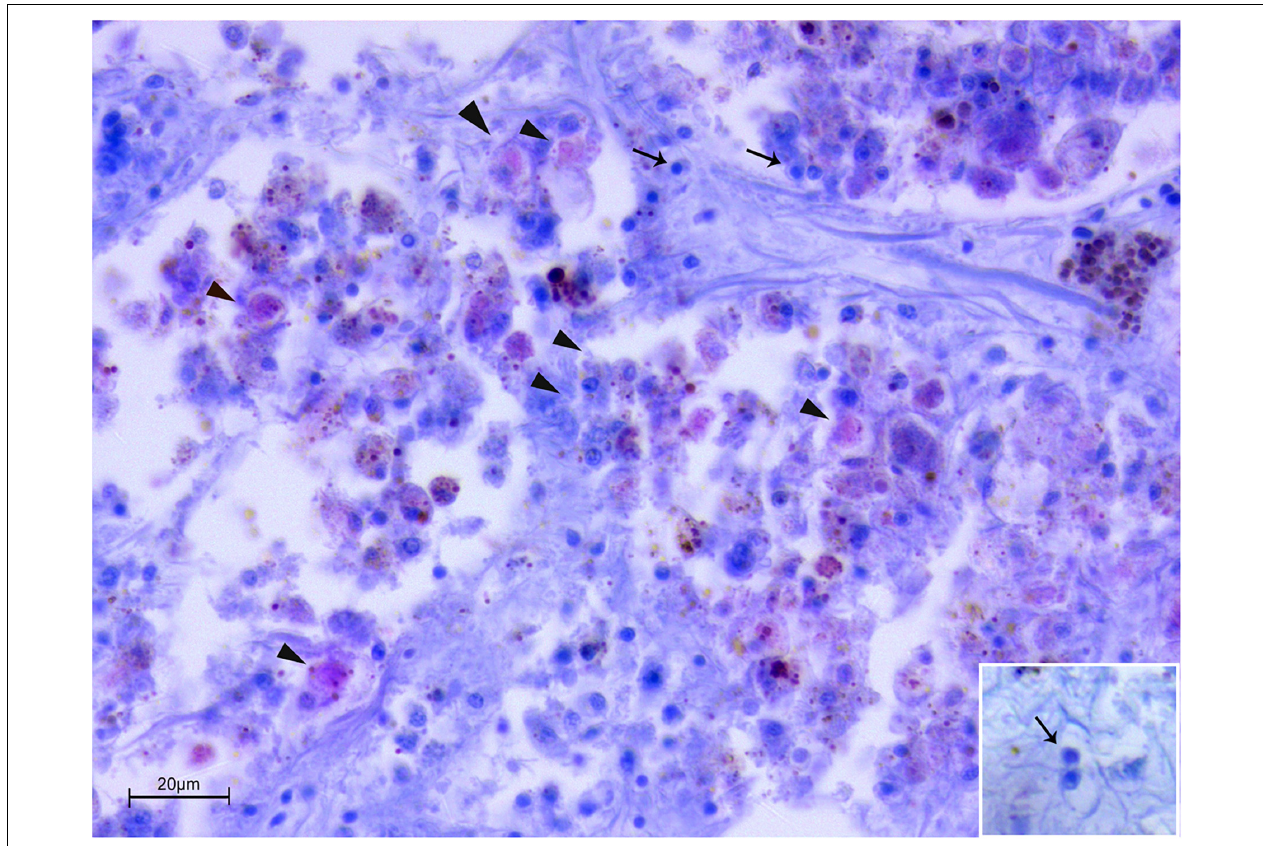
FIGURE 4 | Co-infection by Mycobacterium sp. and H. pinnae in samples of P. nobilis from Catalunya (ZN stain). Presence of Mycobacterium filling immune cells (arrowheads) forming nodules accompanied by the presence of plasmodium phases of H. pinnae (arrows) and